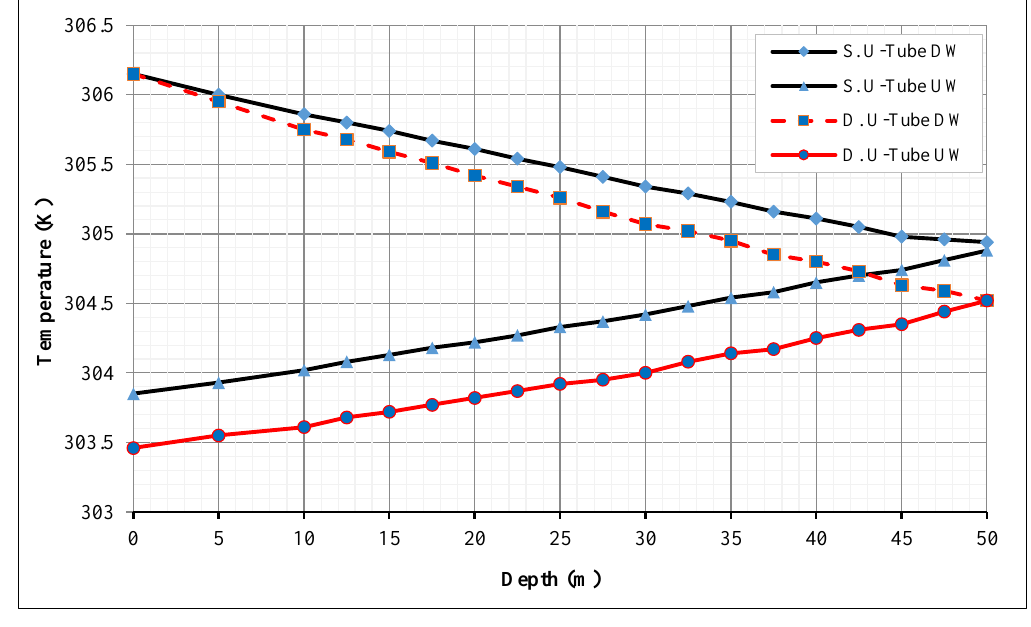
Figure 7.a. Water flow velocity of (0.5) m/s